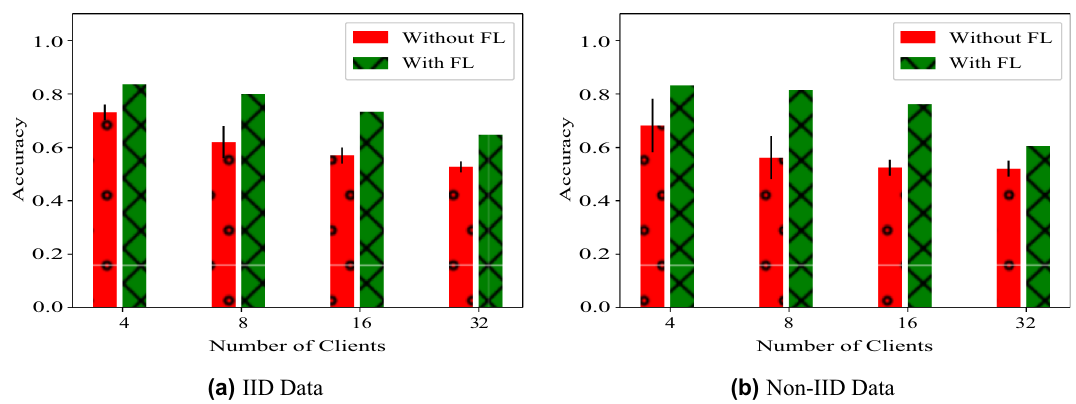
Figure 4. Comparison of the mean accuracy across clients versus the accuracy of the central model trained with FL for the fabricated clients (not the real hospitals). The accuracy is computed on two types of data distribution settings across clients—IID and